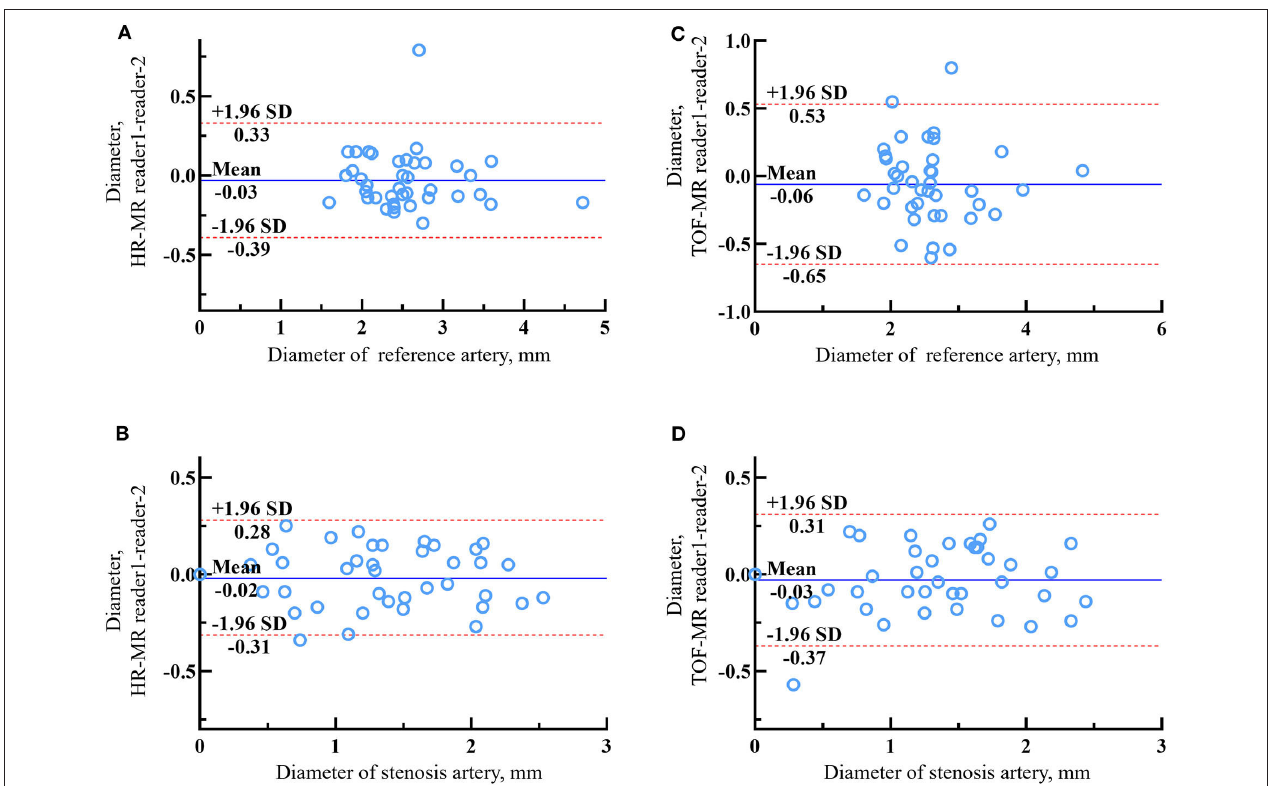
FIGURE 3 | The Bland–Altman plots of lumen diameter measurements between reader 1 and reader 2 of reference artery and stenosis artery on HR-MR images (A,B) and tetralogy of fallot (TOF)-MR images (C,D) . The solid lines represent the mean difference and the dashed lines indicate the 95% limits of